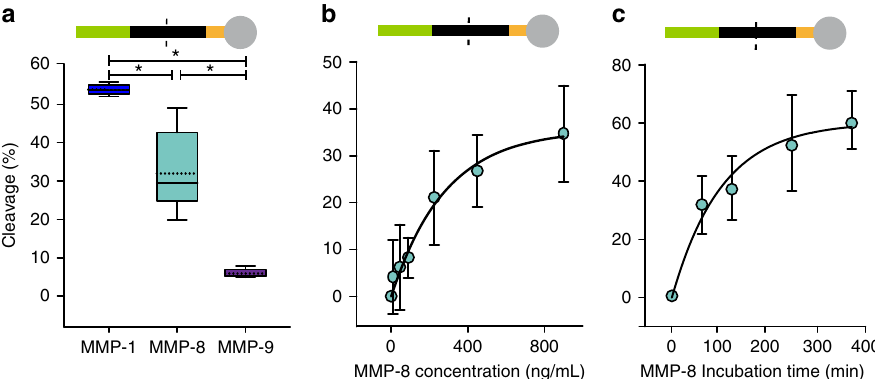
Fig. 4 Cleavage of peptide sensors consisting of microparticle, PCL, and carboxy fl uorescein. a Cleavage (%) of the sensor by MMP-1 n = 5, MMP-8 n = 11, and MMP-9 n = 5. The PCL in the sensor was most sensitive to MMP-1 and to a lesser extent to MMP-8, which in return cleaved the sensor better than MMP-9. Statistical differences among means were assessed by pairwise comparison using a t -test and indicated by asterisks ( p < 0.05). Box-and-whisker plots show the median ( solid line ) and mean ( dotted line ) and whiskers indicate the upper and lower 25%, respectively. b Sensor cleavage (%) as a function of MMP-8 concentration (incubation for 60 min) n = 7 and c over time at a concentration of 900 ng/mL n = 9. All data are presented as mean ± s.d. and each experiment was repeated at least once